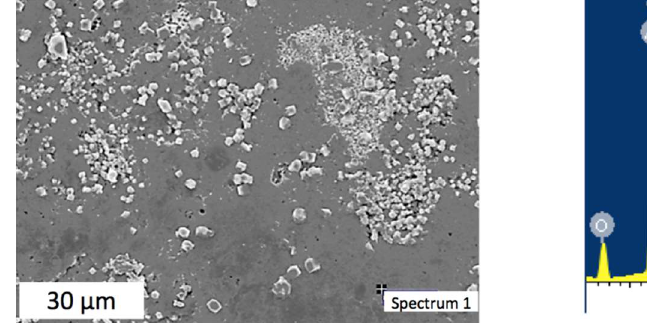
Figure 7. Elemental analysis in point 1 of the sample #4. Table 1. Elemental proportions in point 1 of the sample #4.